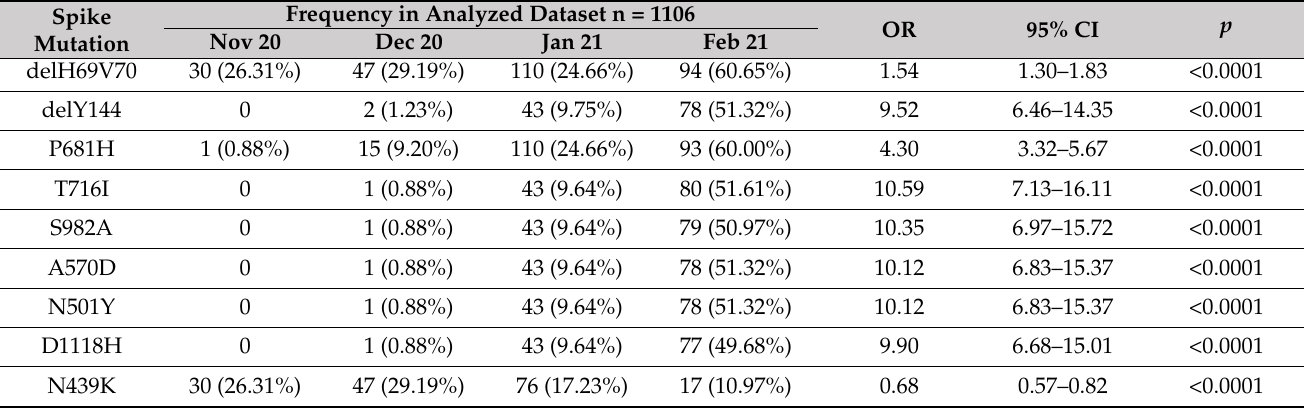
Table 2. Time trends for missense mutations in spike